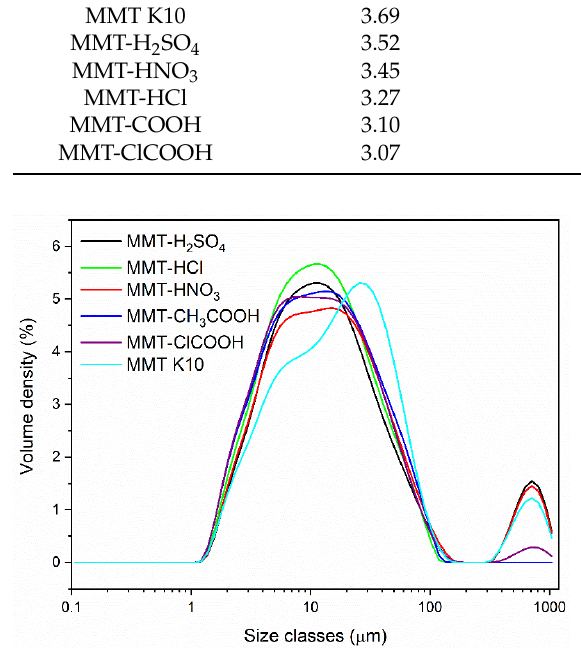
Figure 2. Particle size distribution curves.